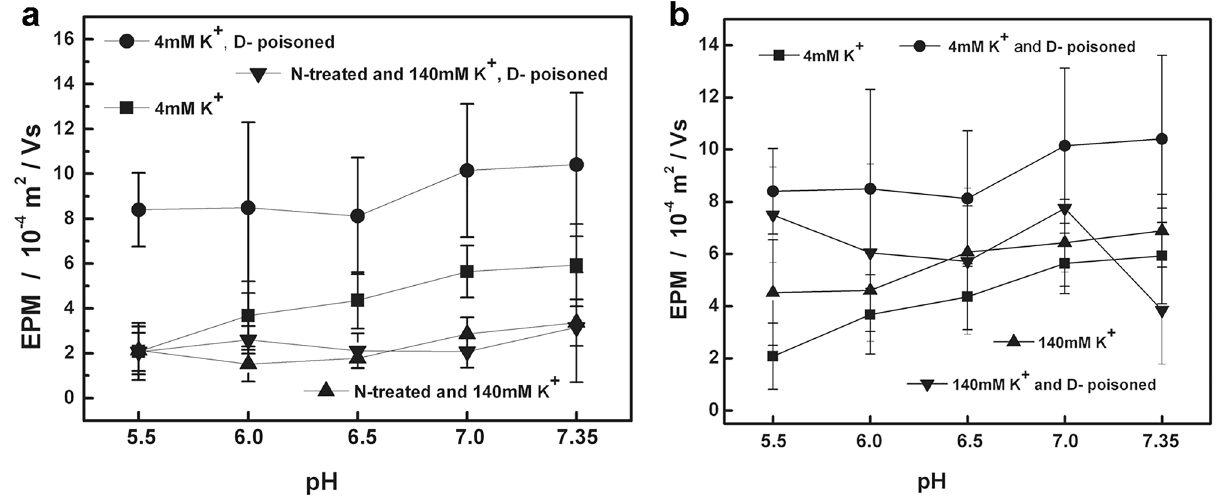
Figure 4. Comparison of the effects of digoxin poisoning dose on cardiomyocytes EPM with different potential components. The annotations are shown in Figs. 1a, 2a and